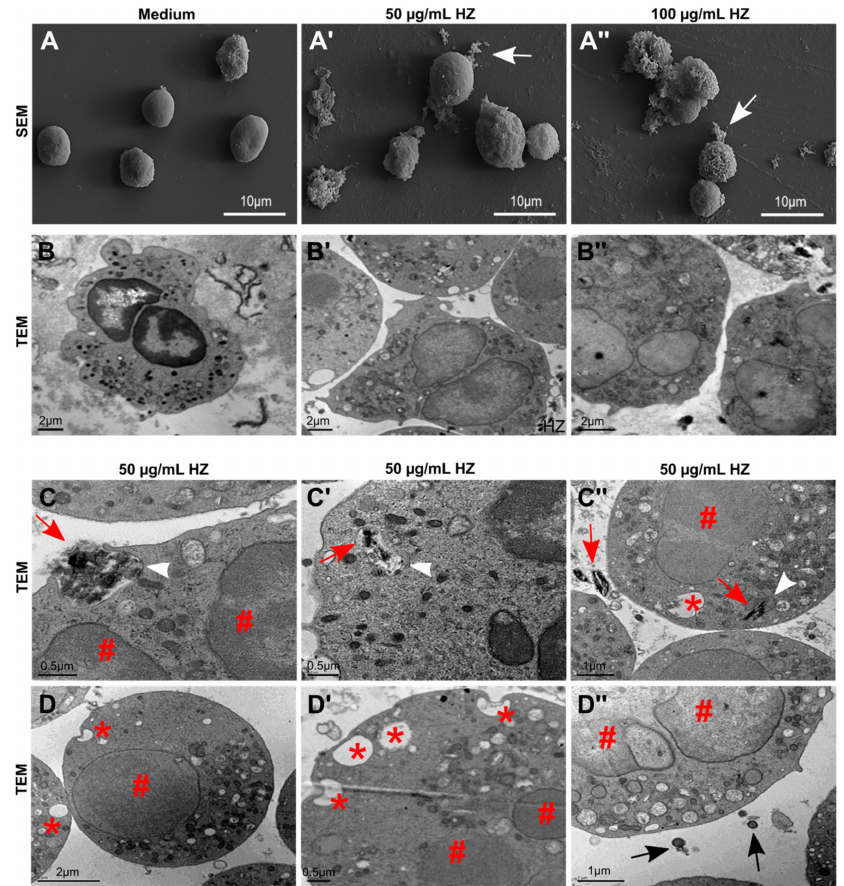
Figure 2. Hemozoin uptake induces nuclei enlargement, and intra- and extracellular vesicle formation in neutrophils but not neutrophil extracellular trap (NET) formation. Human neutrophils were isolated from healthy volunteers and cultured in the presence or absence of HZ (50 and 100 µ g / mL) in RPMI medium for 2 h. ( A – C ) After stimulation, neutrophils were prepared for scanning and transmission electron microscopy (SEM and TEM, respectively). ( A ) SEM images of unstimulated neutrophils (( A ) medium) and HZ-activated neutrophils, as indicated by a rough membrane surface and HZ clusters around neutrophils (white arrows) ( A ’, A ”). ( B ) TEM images of unstimulated neutrophils (medium) showed dense nuclear hetero- and euchromatin, numerous granules, and few vesicles ( B ). Internalization of HZ led to loss of heterochromatin and nuclei enlargement (TEM, B ’, B ”). ( C , D ) TEM images of HZ-activated neutrophils showed large HZ aggregates ( C , red arrows), HZ inside phagosomes ( C ’ and C ”, indicated by white arrow heads), granules / endosomes ( C ”, D , D ”), formation of vesicles / vacuoles ( C ”, D , D ’, indicated by *), loss of heterochromatin ( C , C ”, D , D ’, D ”, indicated by #), breakdown of the nuclear membrane ( C ’), and release of extracellular vesicles ( D ”, indicated by black